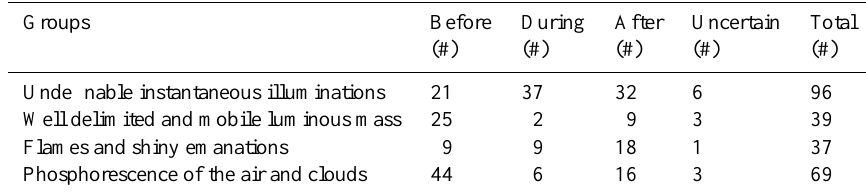
Table 4. The four groups in which the forms can be assembled, according to Galli. Groups Before